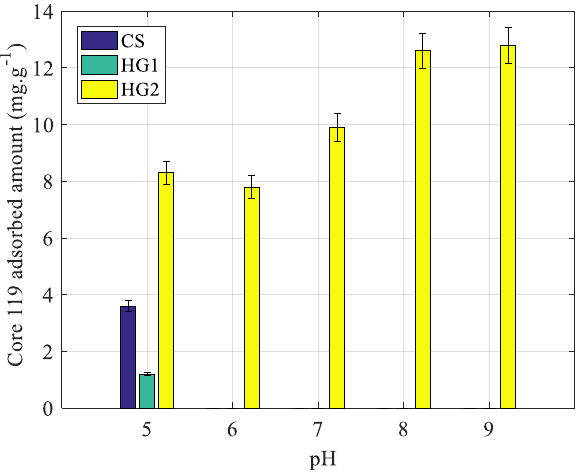
Figure 5. pH influence of Core 119 adsorption onto CS, HG1, and HG2 latexes. Conditions: phosphate buffer at different pH (from 5 to 9), ionic strength 10 mM, adsorption temperature 20 °C.